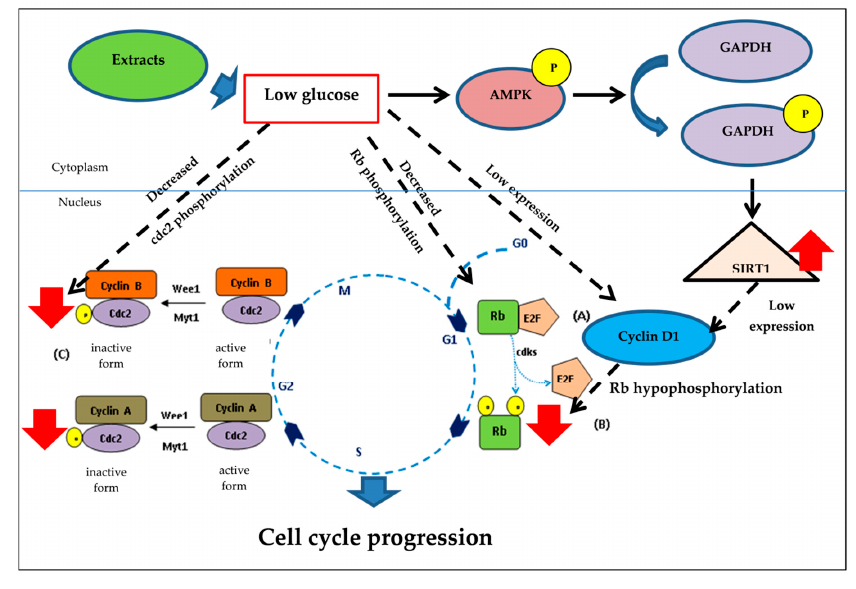
Figure 10. Underlying mechanisms of CHP and CHL exerts and their anti-senescent activity in SH-SY5Y cells. ( a ) In hyperglycemia, hyperphosphorylation of Rb induced by high glucose and cyclin D1 caused cell cycle arrest at G1. Hyperphosphorylated Rb failed to assemble with E2F. Furthermore, pcdc2 was an inactive form that caused cell cycle arrest. ( b ) Both extracts could reduce high glucose level. Low cellular glucose significantly increased GAPDH phosphorylation via AMP-activated protein kinase (AMPK), triggering SIRT1 activation. This mechanism induced the cell cycle progression by decreasing Rb and cdc2 phosphorylation. High expression of proteins ( ); Low expression of proteins ( ); Hyperphosphorylation of proteins ( ); Hypophosphorylation of proteins ( ).